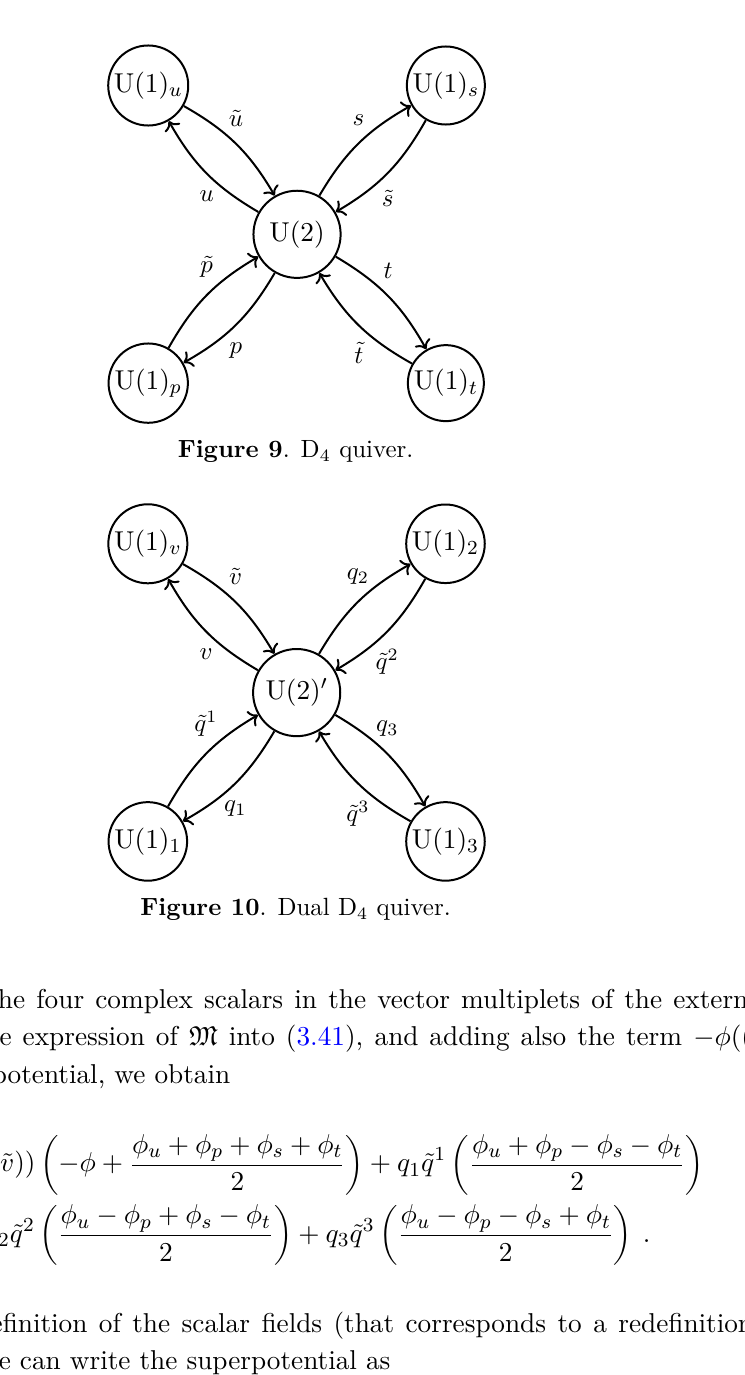
Figure 9 . D 4 quiver.